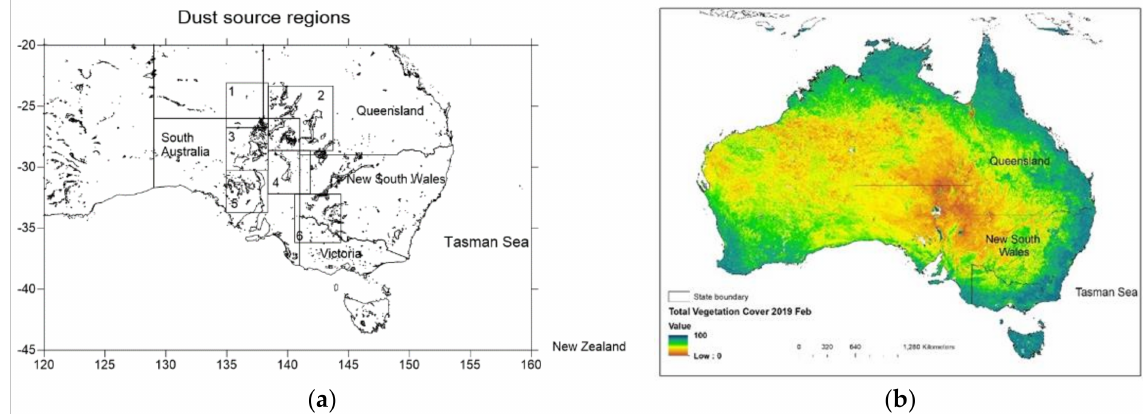
Figure 3. ( a ) Six dust source regions as of O’Loingsigh et al., 2017 [32]: (1) Northern Simpson desert (2) Queensland Channel Country (3) Lake Eyre and South Simpson desert ephemeral lakes region (4) South Strzelecki desert and Lake Frome sub basin (5) Lake Torrens and Gairdner region (6) Mallee and Western Riverina regions. ( b ) Vegetation cover (%) for February 2019 in Australia (source: http://www-data.wron.csiro.au/remotesensing/MODIS/products/public/v310/australia/